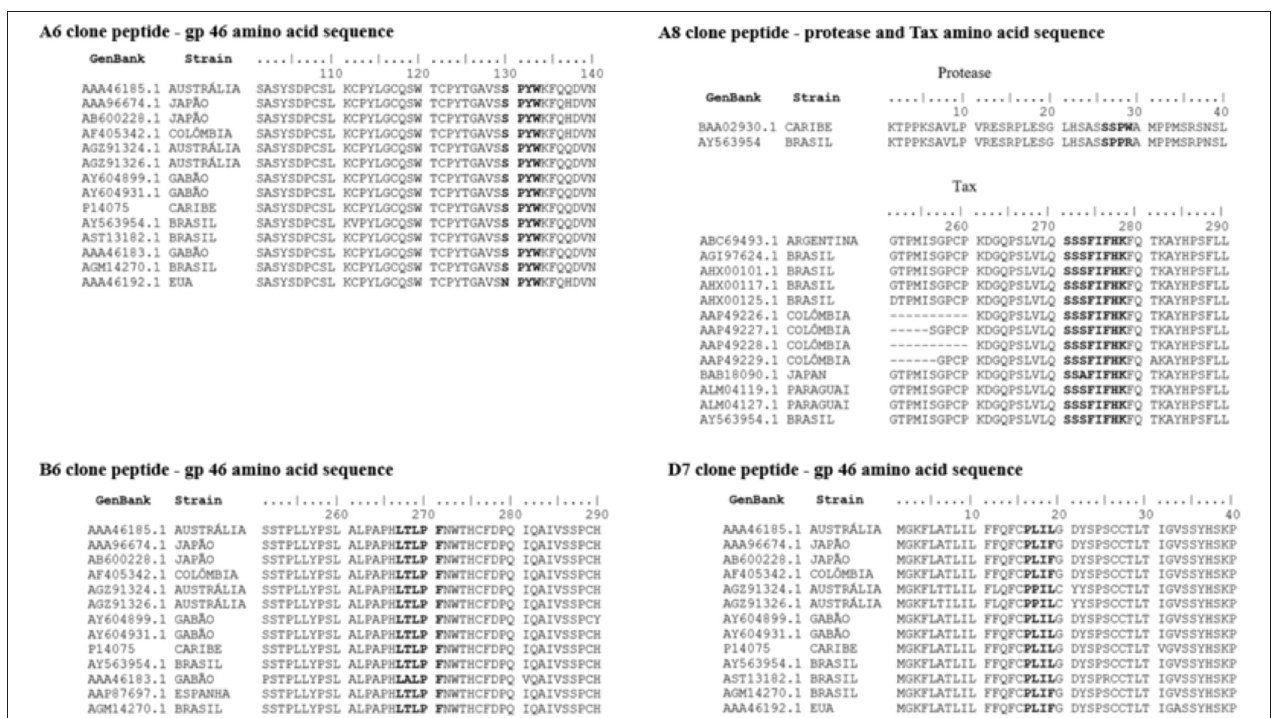
FIGURE 3 | ROC curve of mimetic peptides with AUC values ( Area Under Curve ).